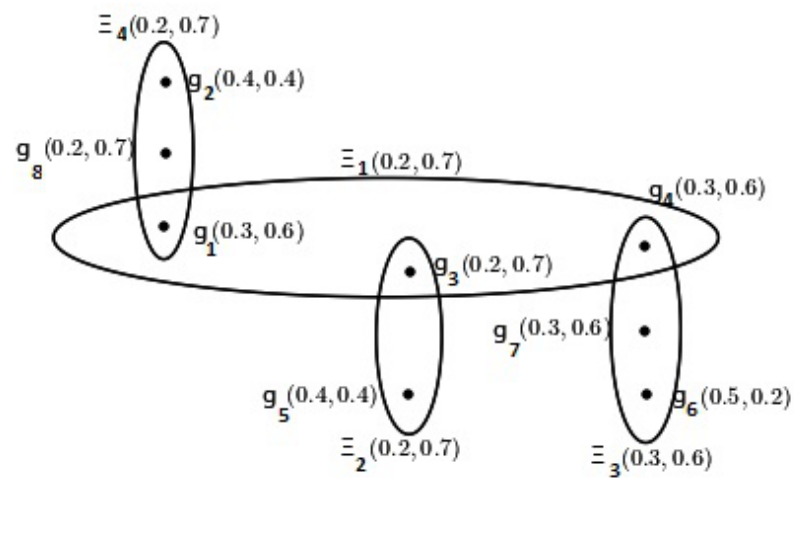
Figure 1: Intuitionistic Fuzzy